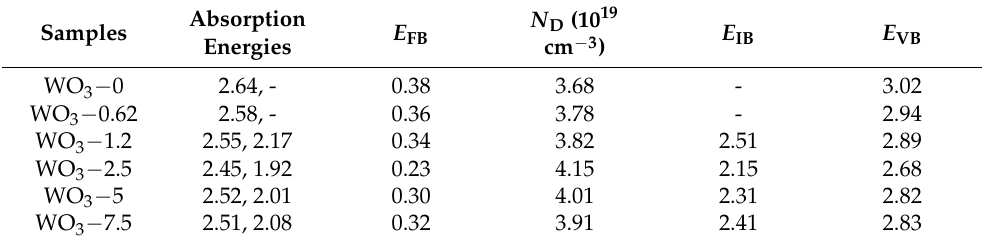
Figure 6. ( A ) UV-Visible DRS and ( B ) Tauc plots based on (a) WO 3 − 0, (b) WO 3 − 0.62, (c) WO 3 − 1.2, (d) WO 3 − 2.5, (e) WO 3 − 5, and (f) WO 3 − 7.5. Insets show the magnified spectra near the edges. Table 2. Summary of optical and electrochemical properties and energies of band structures of various WO 3